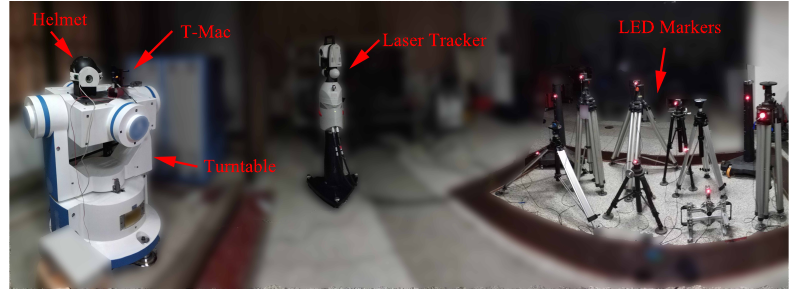
Figure 17. Dynamic measurement experiment scene.